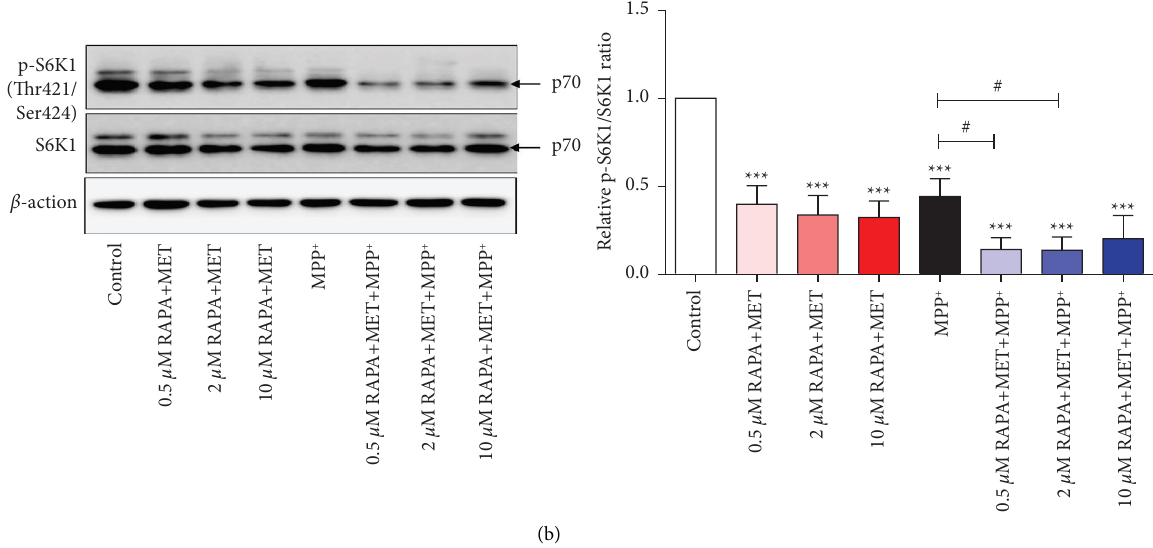
Figure 5: Western blotting analysis of Akt and S6K1 expression in MPP + -treated diferentiated SH-SY5Y cells pretreated with MET and RAPA combinations. After pretreatment, cells were exposed to 700 μ M MPP + for 24hours. (a) Representative blots of Akt and phospho-Akt and quantifcation of relative ratio of phospho-Akt to total Akt. (b) Representative blots of S6K1 and phospho-S6K1 and quantifcation of relative ratio of phospho-A6K1 to total S6K1. Te band density was normalized to β -actin. Values represent mean ± SEM ( n � 3). ∗ p < 0 . 05. ∗∗∗ p < 0 . 001 compared with the control group. # p < 0 . 05. ### p < 0 . 001 compared with the MPP + group.